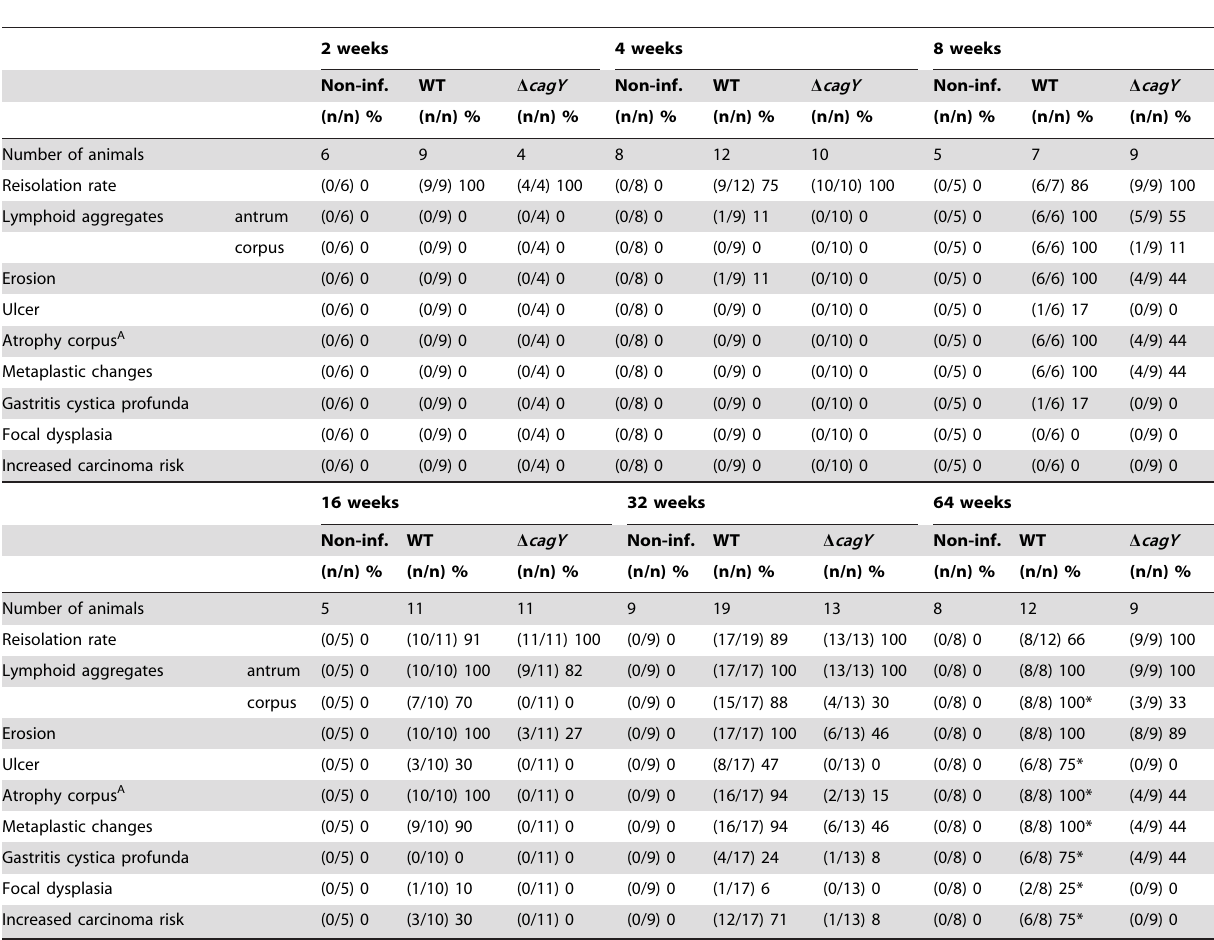
Table 1. Macroscopic and histopathological findings of Helicobacter pylori -infected and non-infected Mongolian gerbils.